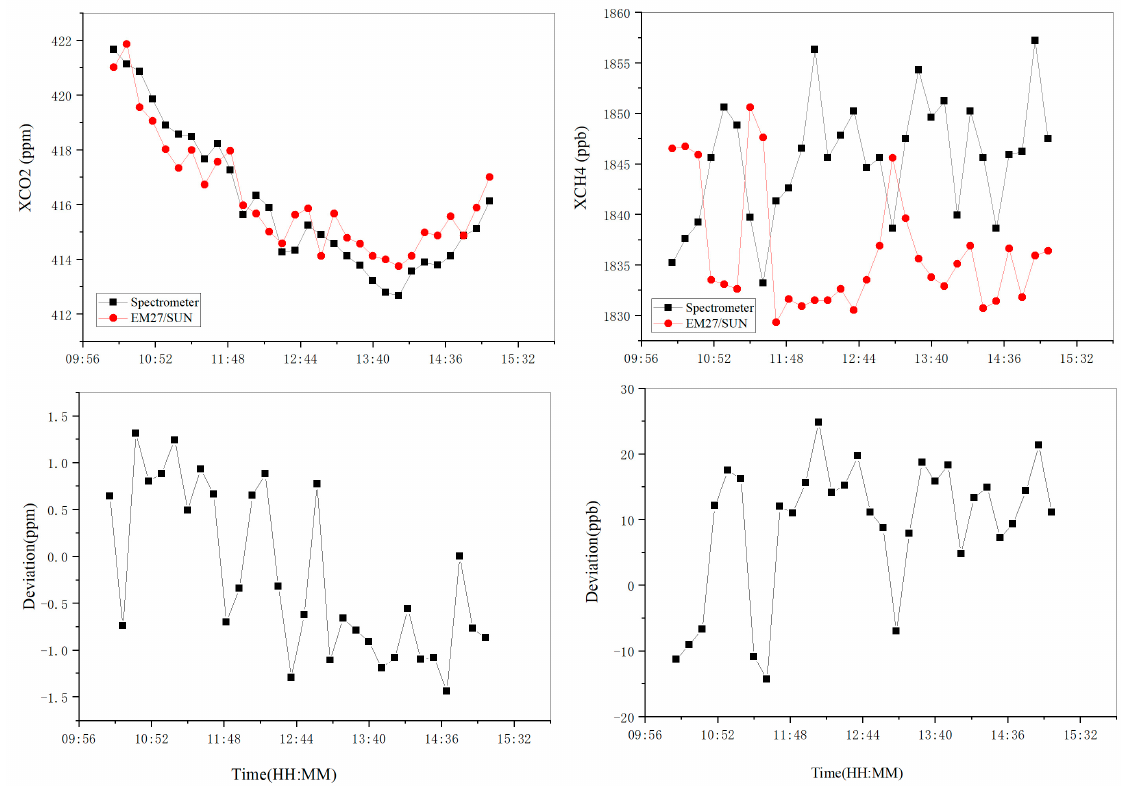
Figure 29. Comparison between spectrometer and EM27/SUN inversion results.